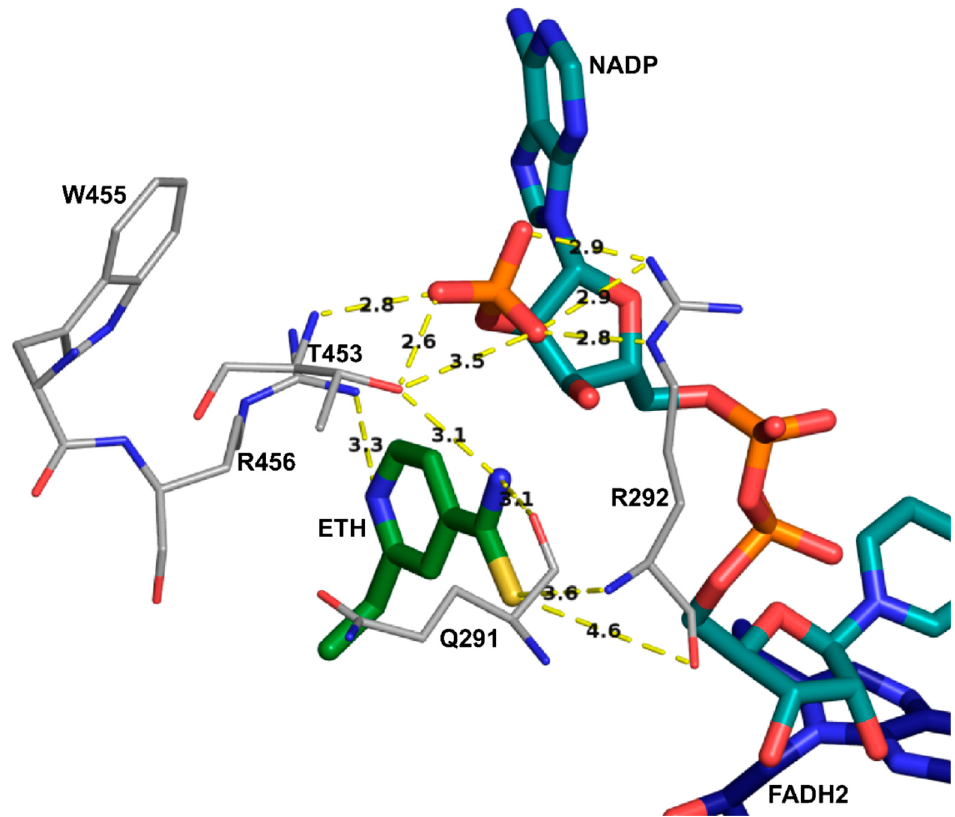
Figure 6. Representation of EthA-ETH complex stabilized during molecular dynamics. ETH (green), NADP (cyan), FADH 2 (blue), and residues (gray) involved in complex stabilization and catalytic mechanism are shown in stick representation. The distance (Å) between ETH, NADP and EthA residues are represented by yellow dashes.